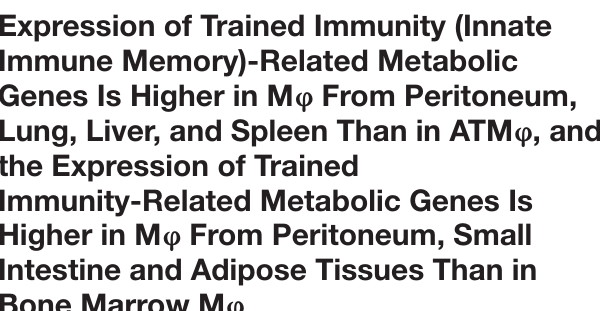
TABLE 4A | Mechanism II: M1 polarization promotes the expressions of M1- and M2c-transcription factors (TFs; NFkB1, NFkB2, and NR3C1) but inhibits the expression of M2a TF PPARg; M2 polarization specifically upregulates M2a TF KLF4, and M1 macrophages (M ϕ ) express higher levels of TFs, STAT1, STAT2, STAT3, and NF-kB than M0 M ϕ .